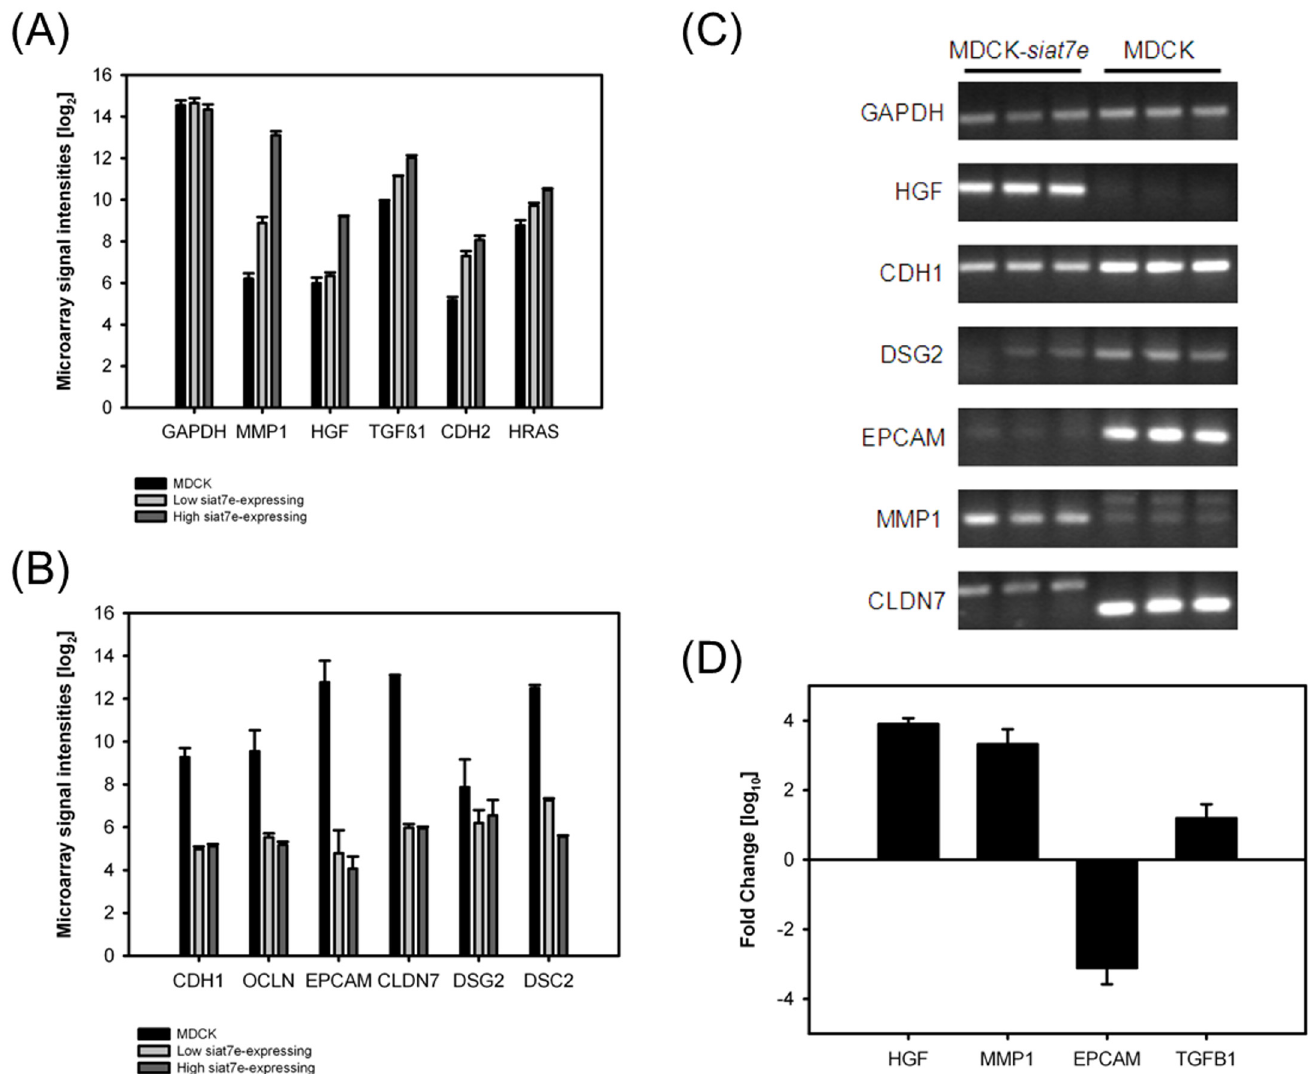
Fig 1. Genes identified from DNA microarray analysis with similar expression trends as the siat7e gene. (A) Highly up-regulated genes in MDCK- siat7e cells. (B) Highly down-regulated genes in MDCK- siat7e cells. (C) End-point PCR confirmation on selected genes using biological replicate samples. (D) Taqman assay results of selected genes (normalized against parental MDCK